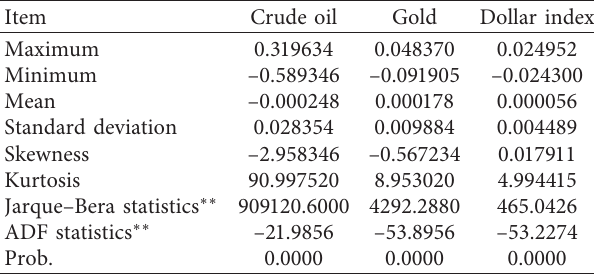
Figure 1: The daily logarithmic return of crude oil, gold, and dollar. (a) Oil market. (b) Gold market. (c) Dollar index. Table 1: Descriptive statistics of each market’s return